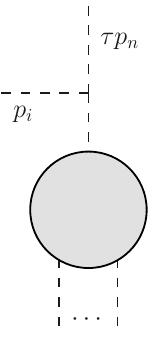
Figure 10 . The “pole diagrams” giving O ( τ − 1 ) contributions in the φ 3 theory, where the soft leg and another external leg are attached to the same 3-pt vertex, leading to a pole in τ given by the propagator i/ (2 τp ) i · p n